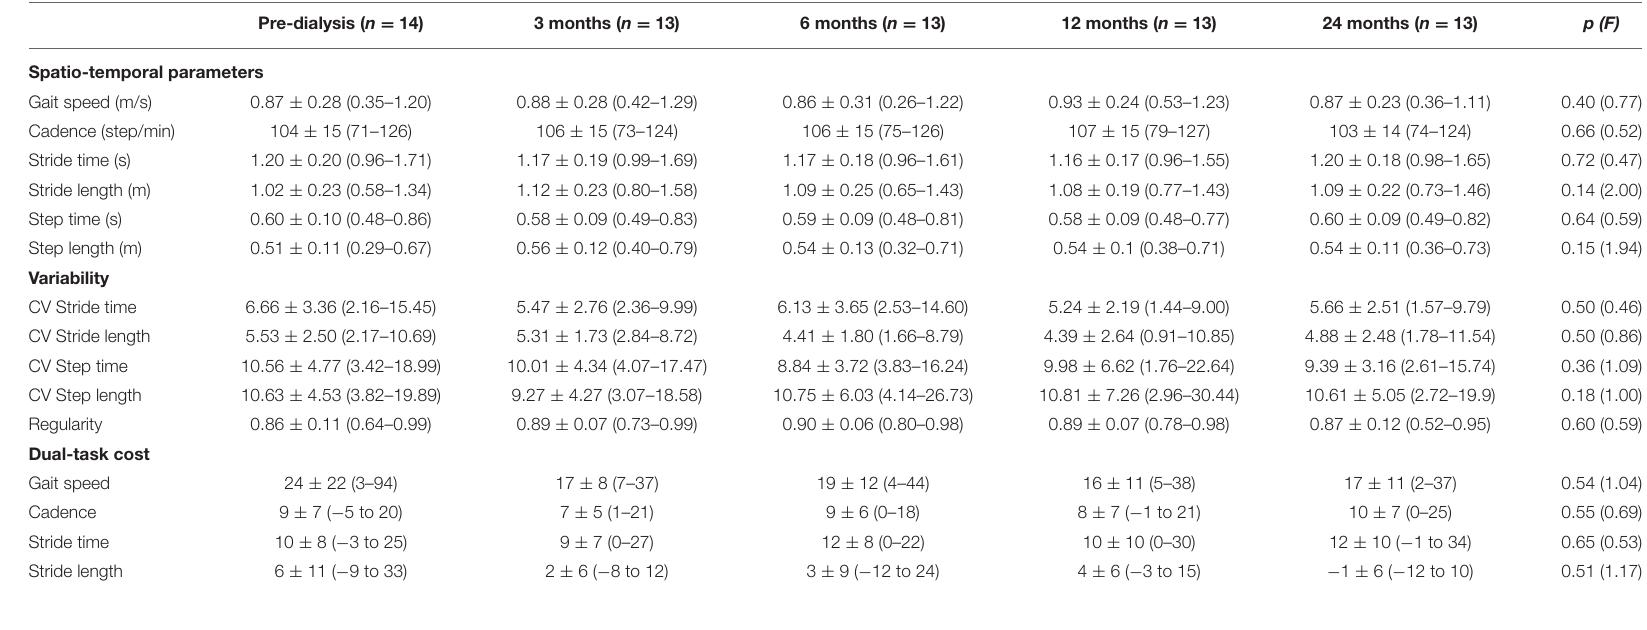
TABLE 2 | Prospective development of spatiotemporal gait parameters [mean ± SD